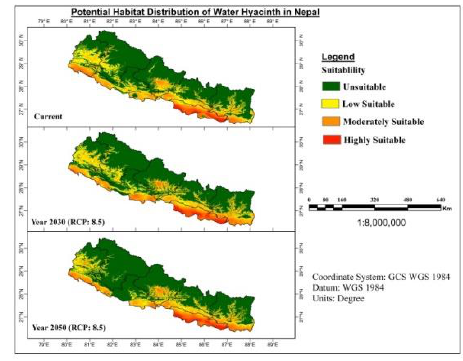
Figure 7. Potential Habitat Distribution under RCP 8.5